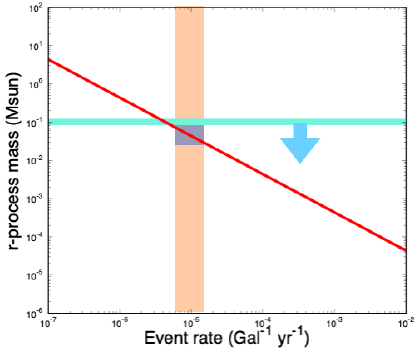
Figure 3. The calculated explosion models on the color-color diagram ( g - i vs g - r ).